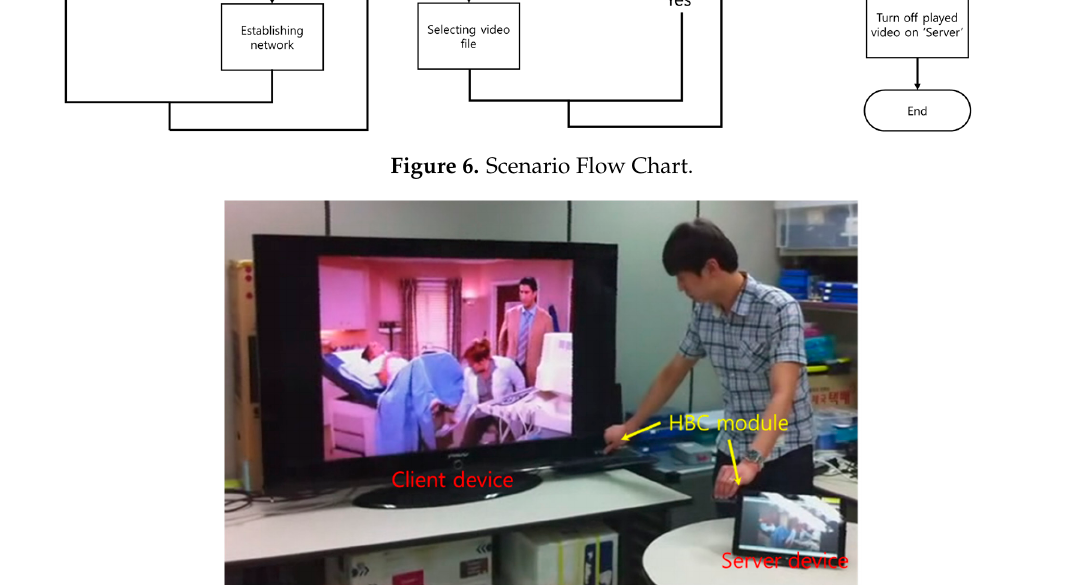
Figure 7. Touch-Based Dual-Band Communication Service demonstration.